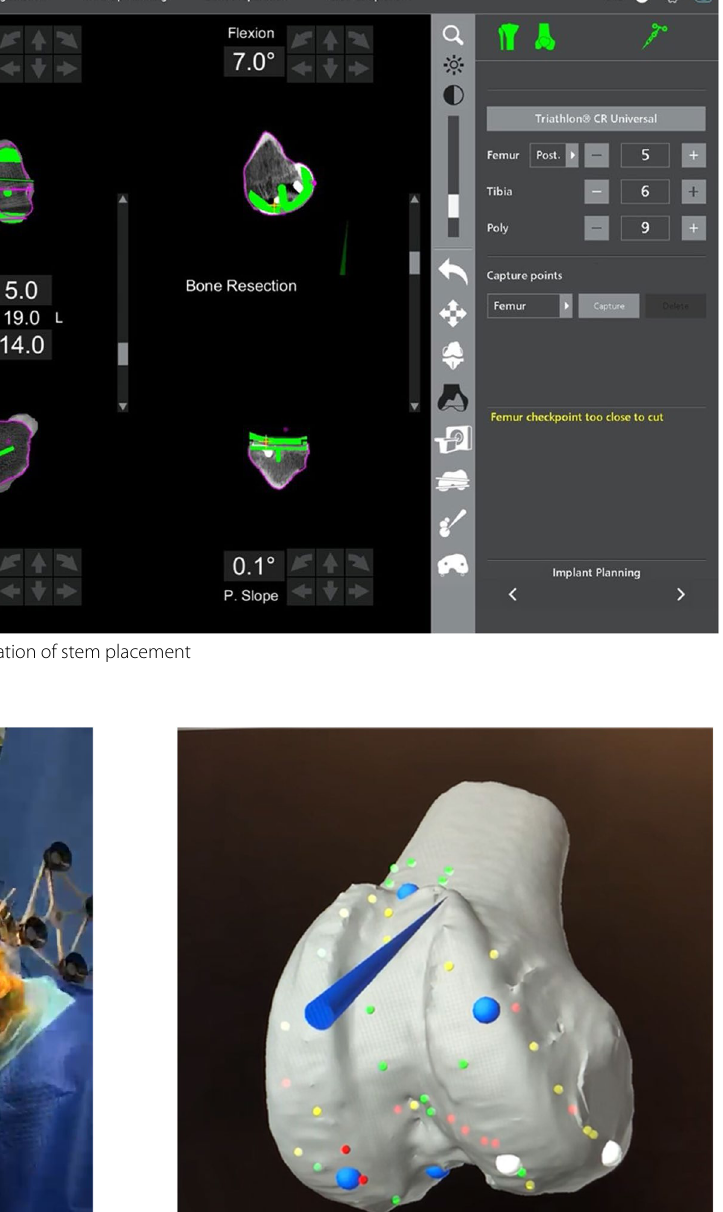
Bony landmark registration Registration of the femoral bony landmarks was com-